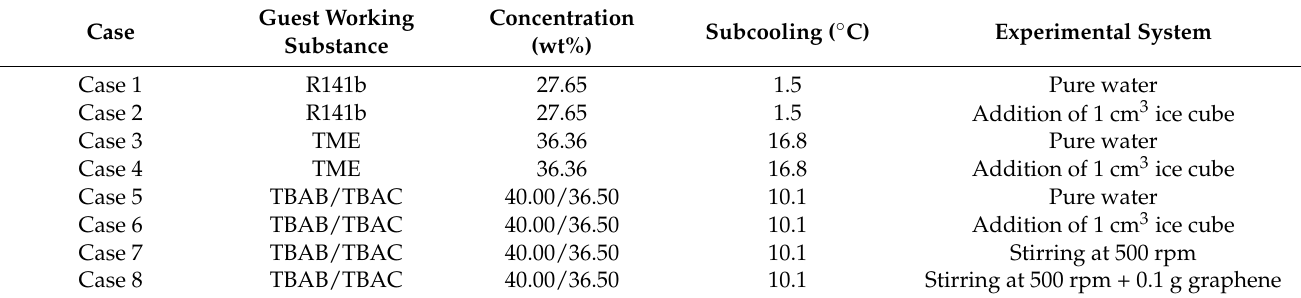
Table 2. Experimental conditions for hydrate formation at 5 ◦ C and 0.1